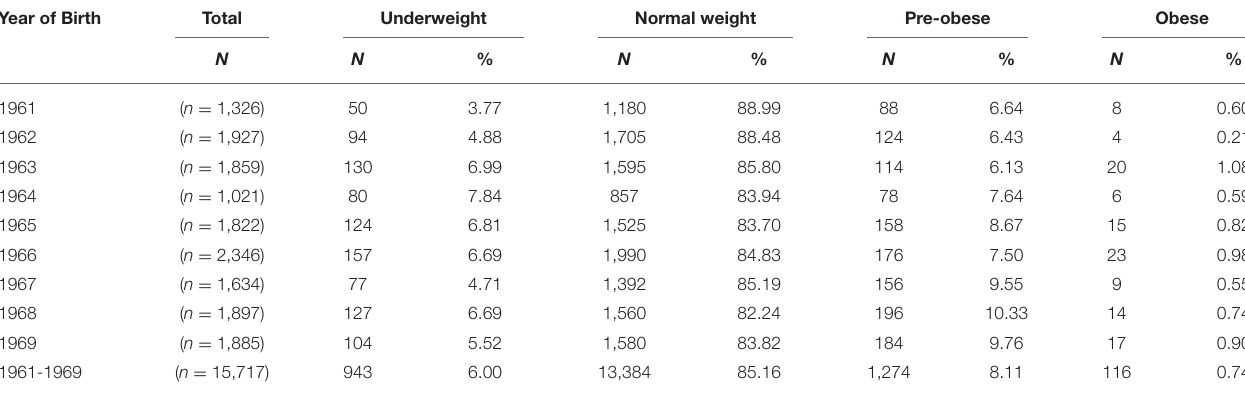
TABLE 2 | The Nutrition Status of Male Adolescents from the Capital City of Montenegro enrolled in the study. Year of Birth Total Underweight Normal weight Pre-obese Obese N N %